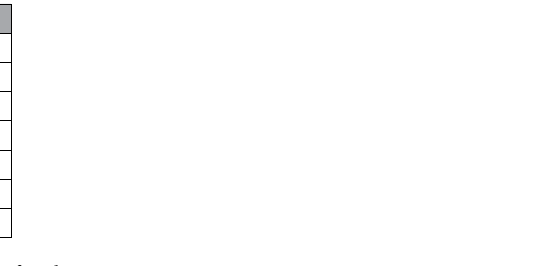
Table 7. The input and output feature map size of each